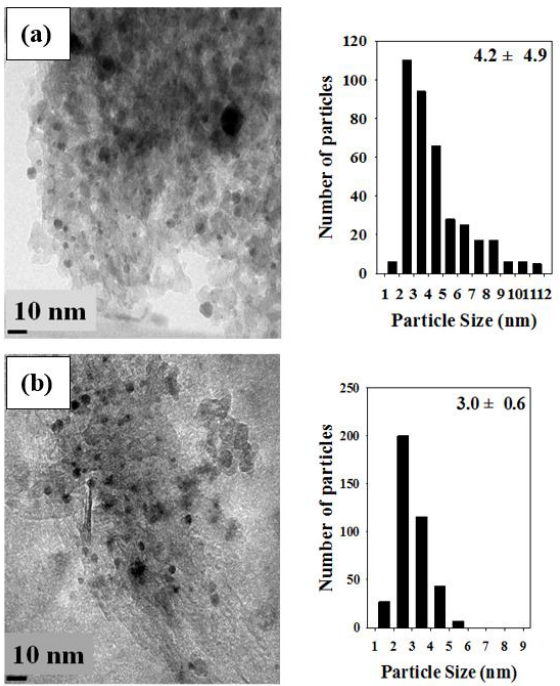
Figure 2. TEM images and gold size distributions of various Au/La 2 O 3 /Al 2 O 3 catalysts: ( a ) Au/La 2 O 3 /Al 2 O 3 (S35); ( b ) Au/La 2 O 3 /Al 2 O 3 (G).